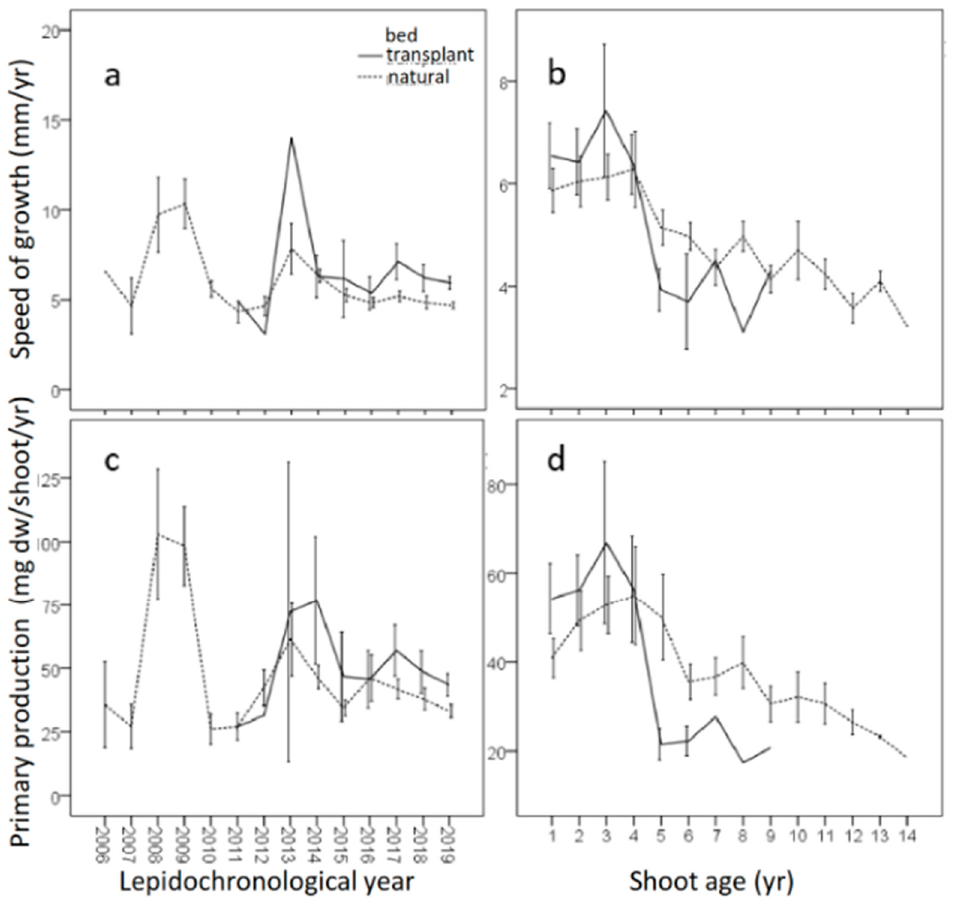
Figure 7. Mean values (SE) of speed of growth ( a ), primary production ( c ) across lepidochronological years and shoot age ( b , d ).